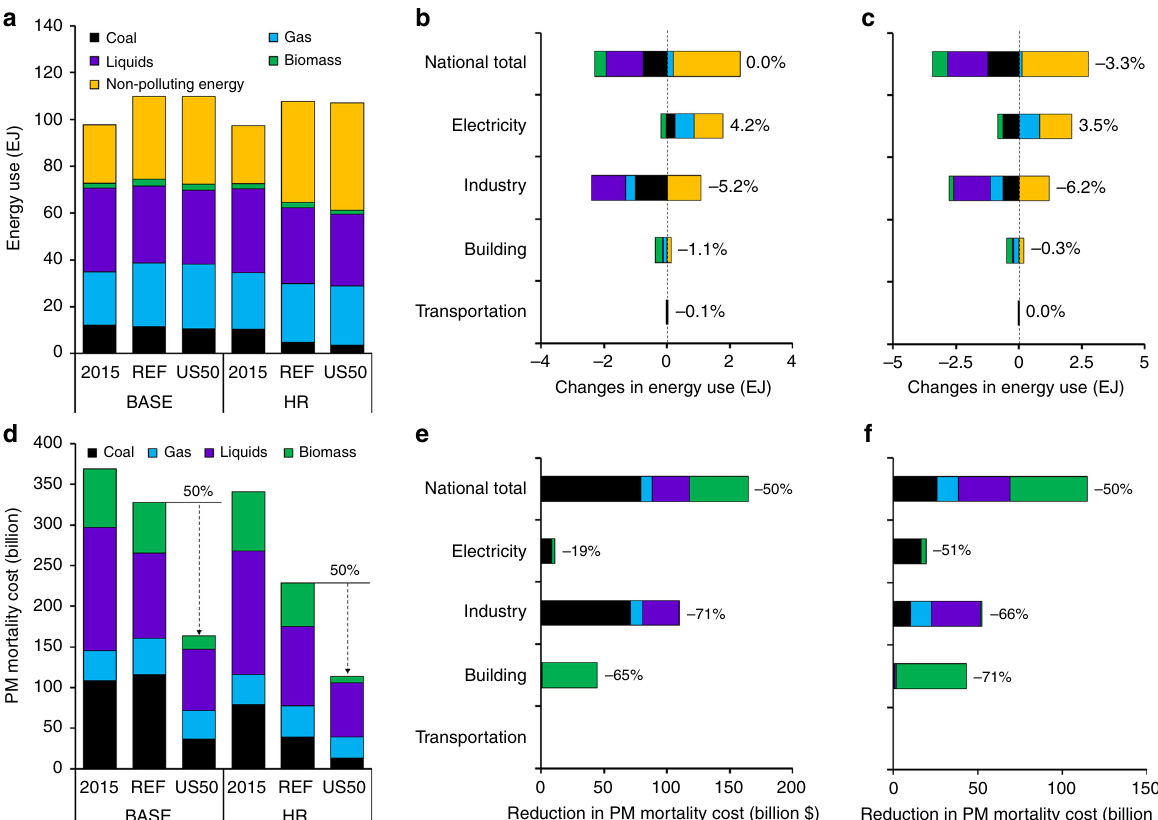
Fig. 1 National energy system and PM 2.5 mortality cost responses to the 50% PM 2.5 mortality cost reduction (US50) based on two reference scenarios. National total energy use (EJ) by fuel ( a ), sectoral changes in energy use (EJ) by fuel for BASE US50 relative to BASE REF ( b ) and HR US50 relative to HR REF ( c ); national total PM 2.5 mortality costs (billion 2018$) by fuel ( d ), and sectoral changes in PM 2.5 mortality costs (billion $) by fuel for US50 reductions under BASE ( e ), and HR scenarios ( f ). With the exception of the bars labeled 2015, all values are for 2050. Changes in the transportation sector are negligible. The nonpolluting energy category includes geothermal, hydropower, wind, and solar power in the electricity sector, and hydrogen and electricity in end-use sectors. Source data are provided as a Source Data fi